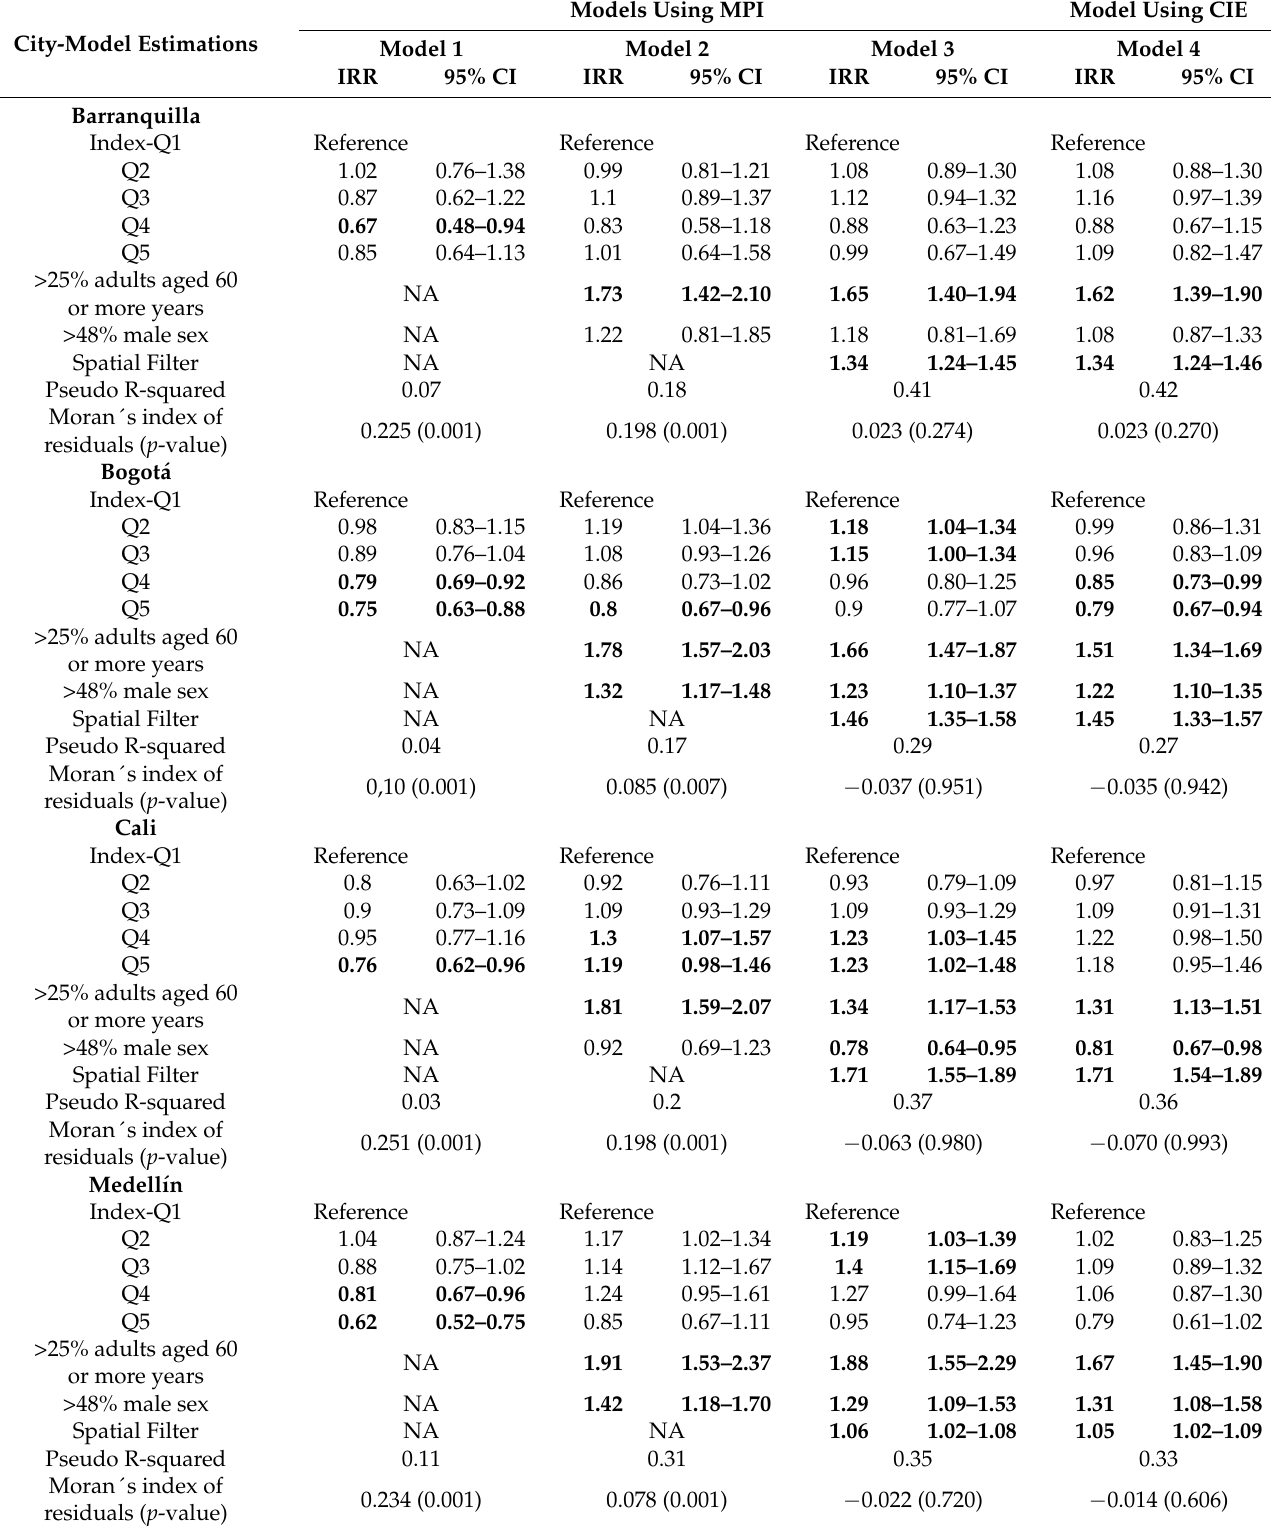
Table 3. Multivariable Poisson regression models on the association between smoothed Bayesian mortality rates for all deaths and quintiles of multidimensional poverty index (MPI) and concentration index at extremes (CIE) for selected cities in Colombia,